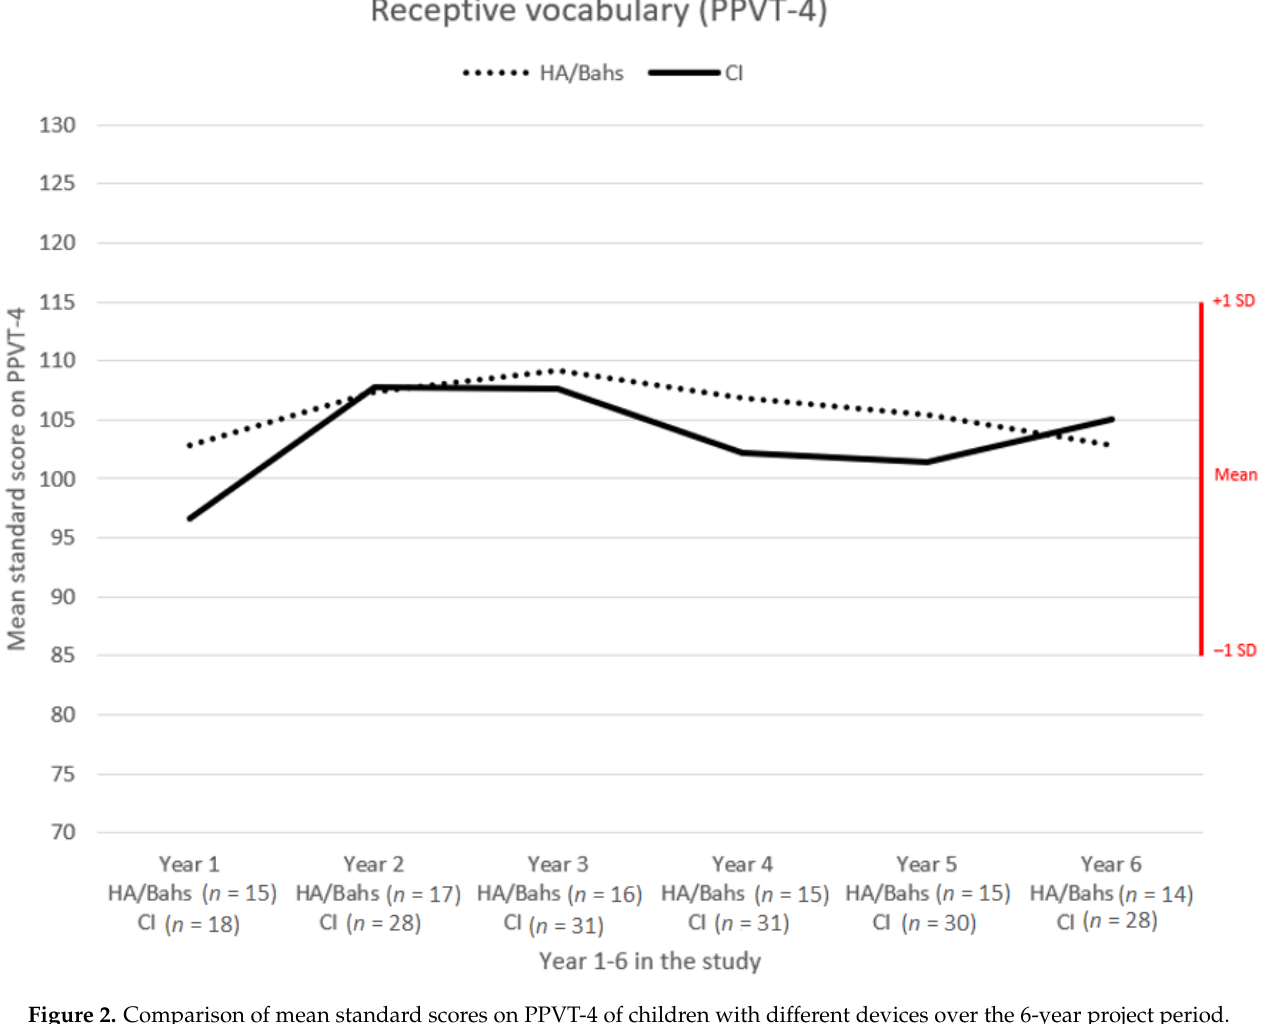
8 of 14 Table 2. Categories of standard scores vs. level of social well-being and device at year 3 and 6. Standard Score PPVT-4